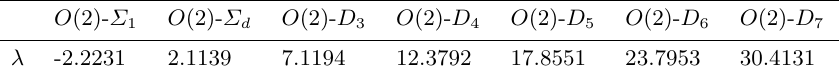
Table 1. Symmetry-breaking bifurcation point for λ continuation with p = 3 , κ = − 1 and l = 2.